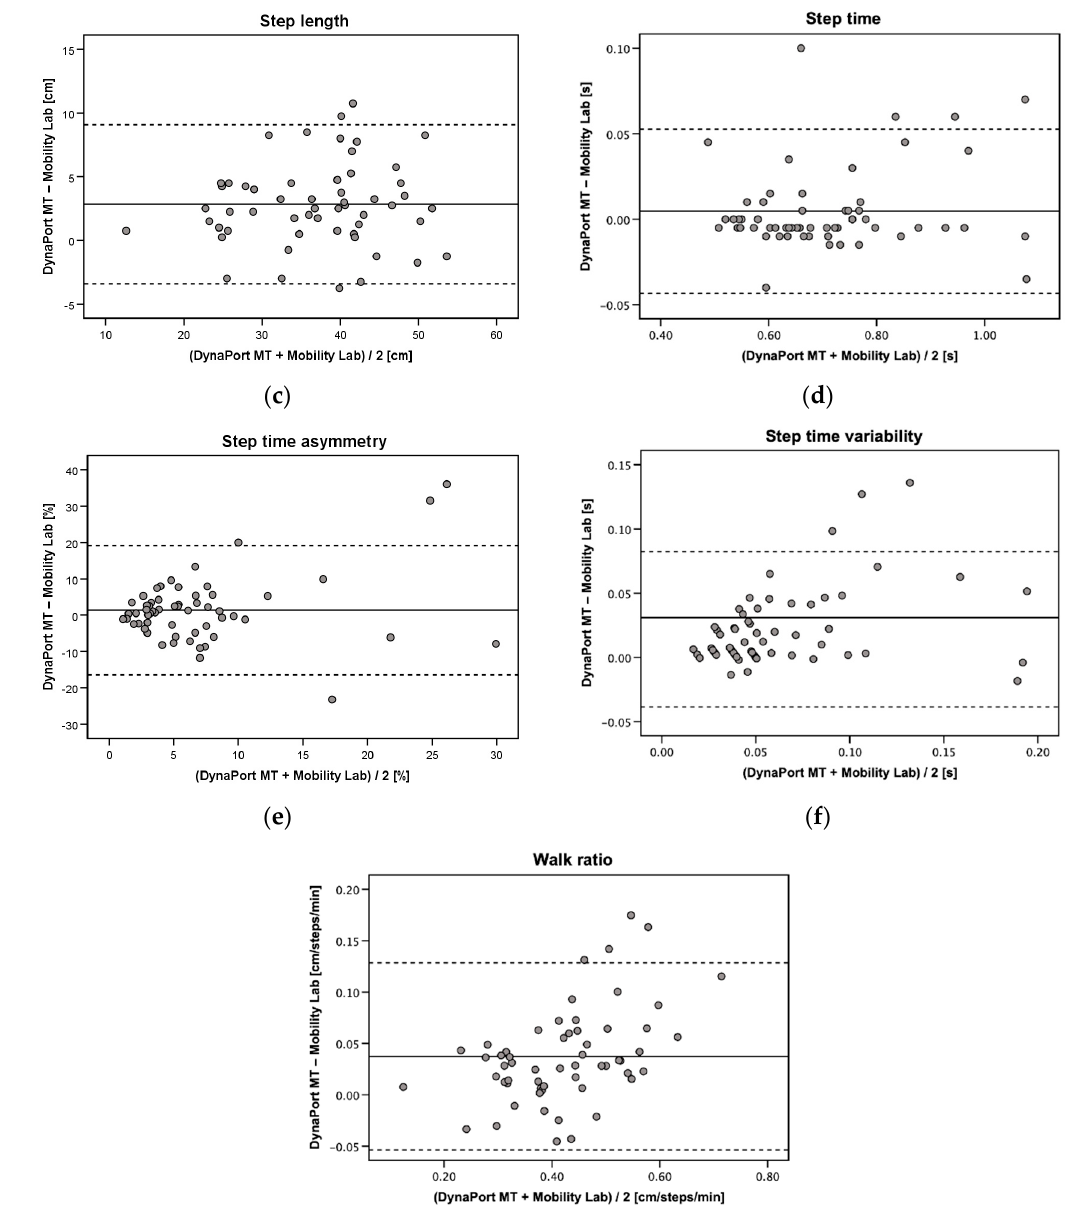
Figure 2. Bland–Altman plots for ( a ) gait speed, ( b ) cadence, ( c ) step length, ( d ) step time, ( e ) step time asymmetry, ( f ) step time variability, and ( g ) walk ratio measured with the DynaPort MT and the Mobility Lab (concurrent validity). Solid lines indicate mean between-method differences (bias) and dashed lines indicate upper and lower 95% limits of agreement (±1.96 SD of the bias).